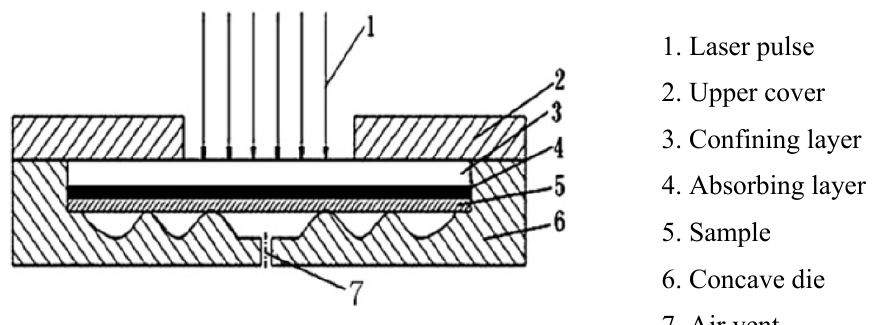
Figure 27. Schematic set-up of metal sheet laser shock forming with concave die [70].